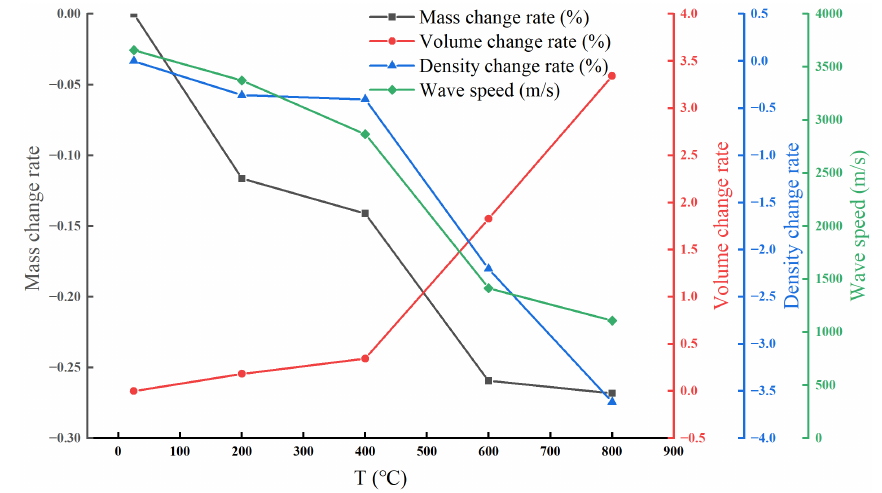
Figure 3. Effect of heat treatment on the physical properties of Beishan